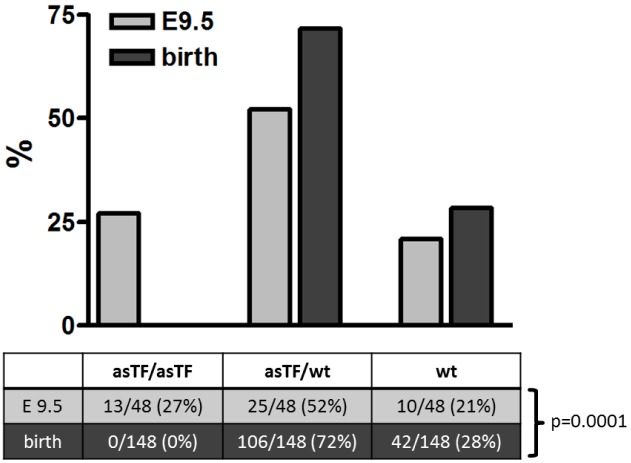
Genotype distribution on E9.5 and birth.Homozygous asTFKI embryos die after developmental day E9.5. Genotype distribution of offspring from heterozygous breeding pairs at birth (black bars) differs from that at embryonic day 9.5 (grey bars). At day 9.5, embryonic genotypes are distributed in a Mendelian manner, while no more homozygous asTFKI pups can be identified at birth (p = 0.0001, χ2-test).